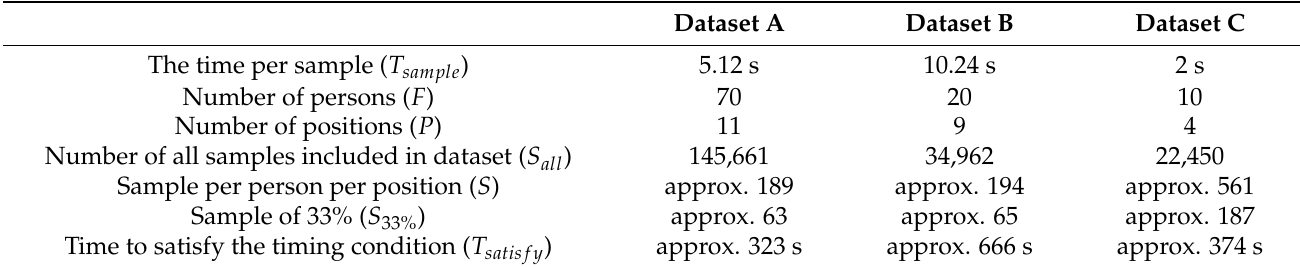
Table 11. Time to satisfy the timing condition and the parameters for